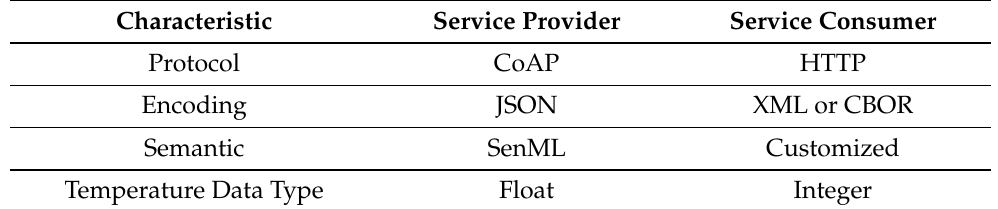
Figure 4. A case scenario that included the Davis Vantage Pro2 weather station, the weather station provider and consumer, the mandatory Arrowhead core system, and the consumer interface generator. Table 2. Interface characteristics.